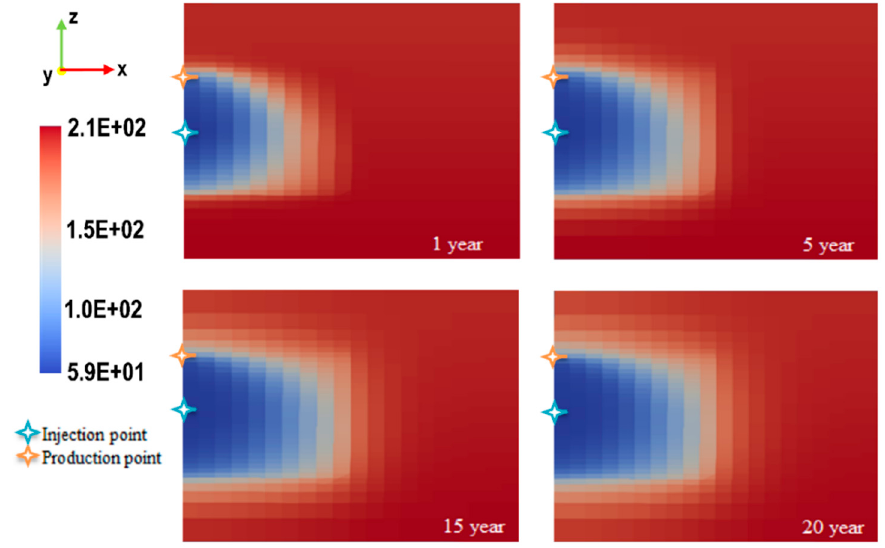
Figure 6 . Temporal evolution of temperature decline in 1st fracture plane after 1, 5, 15, and 20 years of production.